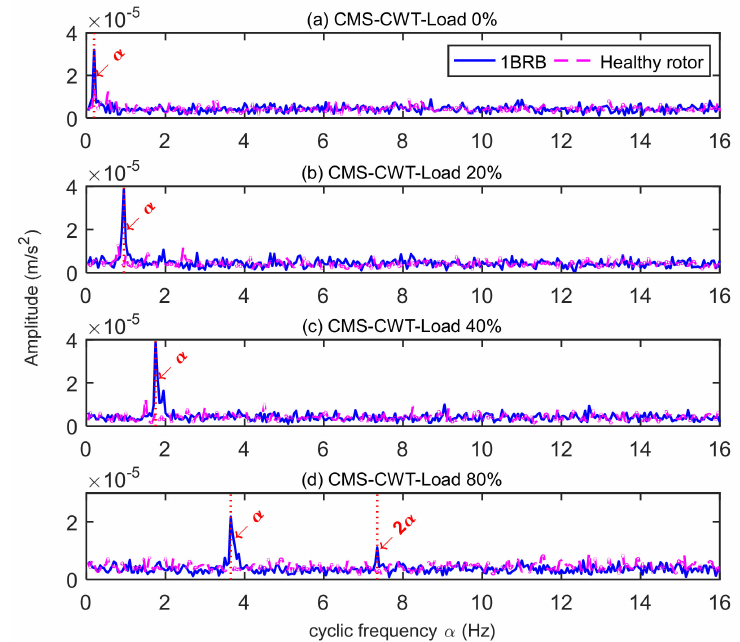
Figure 13. Vibration spectrum of the healthy induction motor and damaged motor with one BRB analyzed by CMS-CWT under ( a ) 0% load, ( b ) 20% load, ( c ) 40% load, and ( d ) 80%